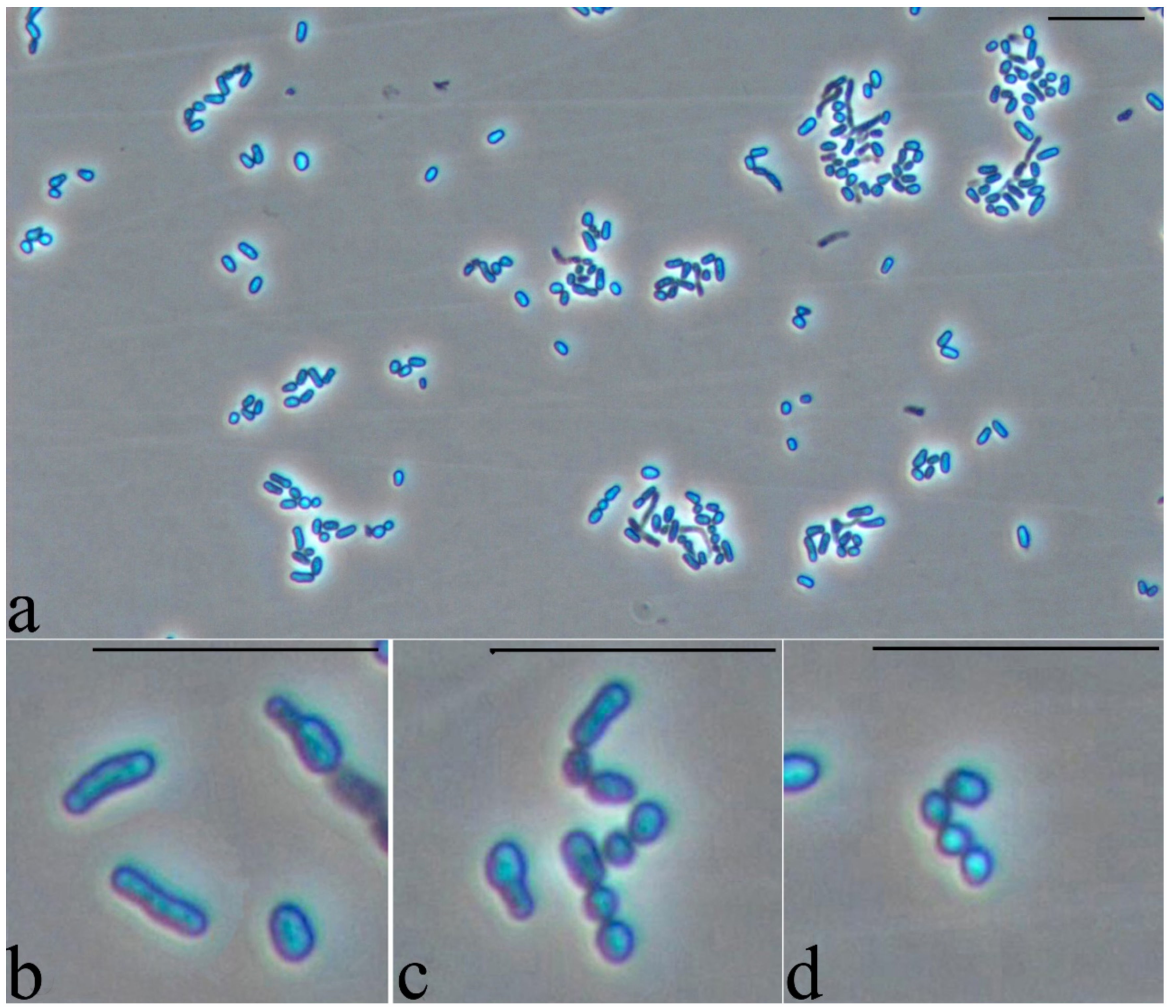
Figure 6. Strain S8 on glucose 4 days of growth. Light microscopy, phase contrast. The length of the scale bar is 10 µ m. Crushing of rod-shaped cells occurs with the formation of chains of small cocci ( a , c , d ). Formation of multiple partitions inside the rod-shaped cell at the initial stages of crushing ( b ). When studying the morphology of cells cultivated in the presence of a hydrophobic substrate, it was found that the cells retain the shape of rods, which indicates active vegeta- tive growth in the presence of a non-toxic substrate. Sorption of the initially hydrophobic substrate (hexadecane) on the cell surface is observed when bacterial cells are “pushed out” from the growth medium on hexadecane during preparation for light microscopy (applying the surface foam material, where the microbial utilization of hexadecane occurs, on a glass slide and pressing the drop with a cover slip) (Figure